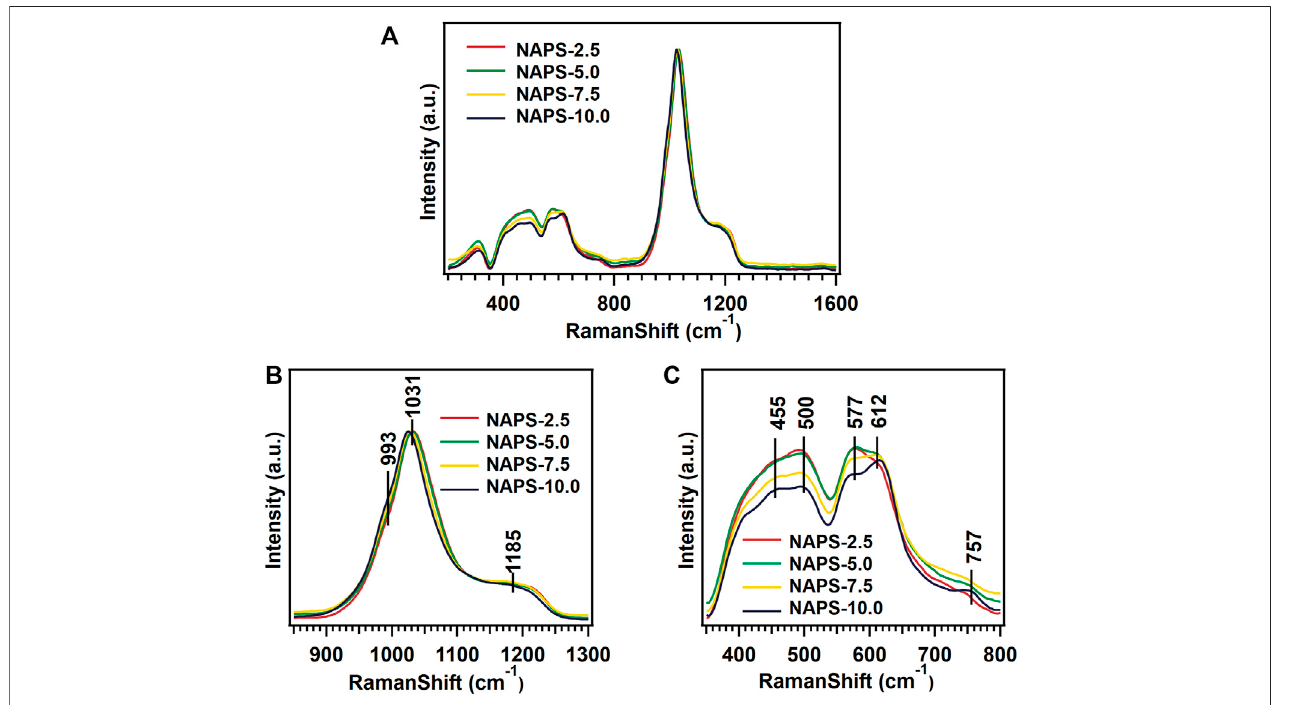
FIGURE 1 | Raman spectra for different glass samples.